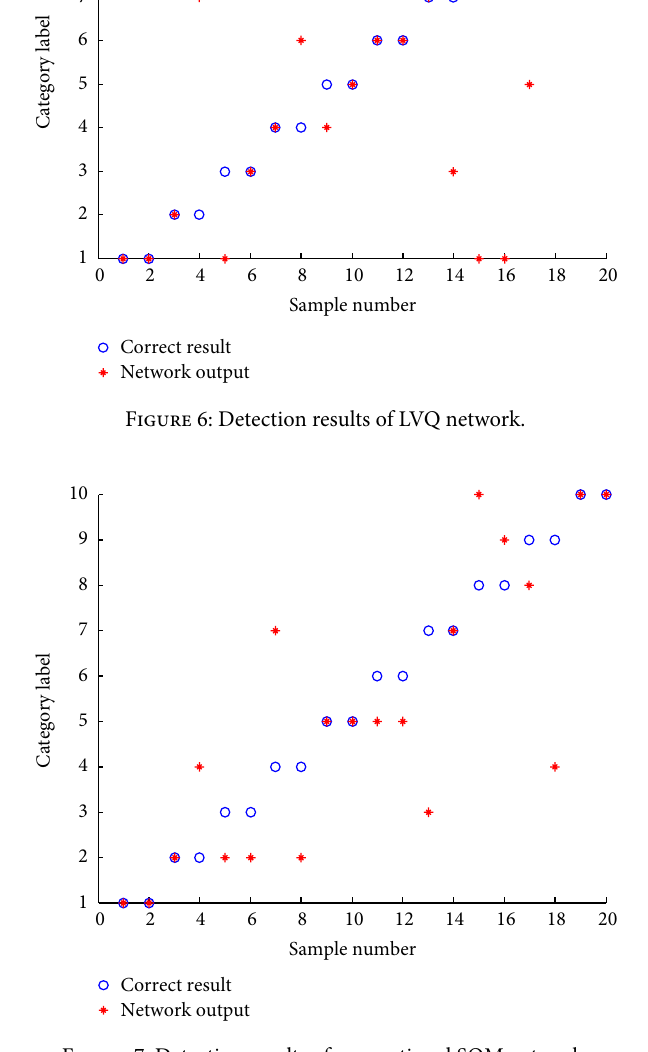
Figure 7: Detection results of conventional SOM network.